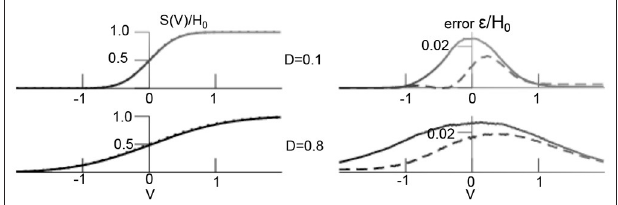
FIGURE 1 | Additive noise shapes non-linear transfer function. (Left) Theoretical transfer function [integral in (24)] (dashed line) and numerical estimation of (24) averaged over 1,000 time points in simulation shown in Figure 4 . (Right) distributions of difference between theoretical and numerical estimation ε (dashed line denotes temporal mean, solid line is temporal variance). Other parameters are D 2 0.5, H 0 1.7, results for the transfer = = function S 2 are